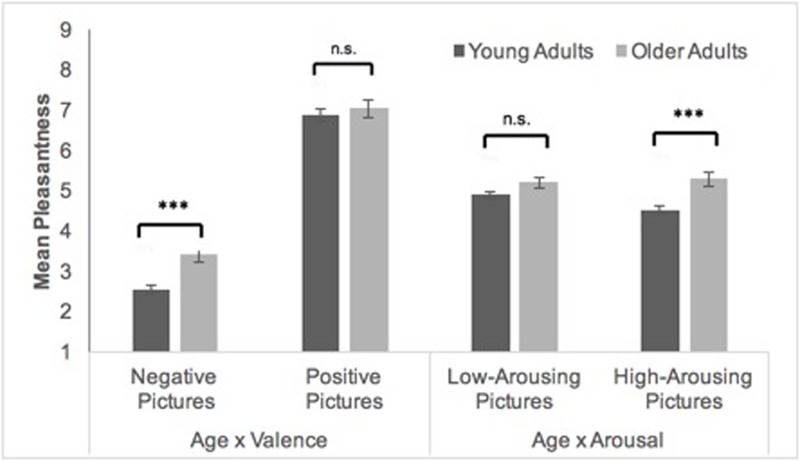
Means (± standard errors) of young (N = 21) and older (N = 19) adults’ pleasantness ratings for negative and positive pictures and for low- and high-arousing pictures. ∗∗∗p < 0.001.